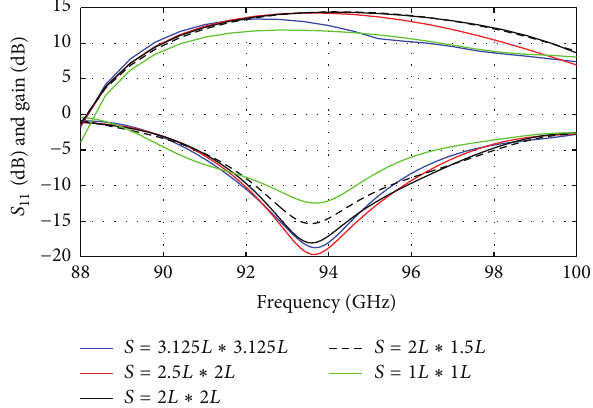
Figure 9: The variation of side lobe level of the antenna with the variation of the thickness of the superstrate.